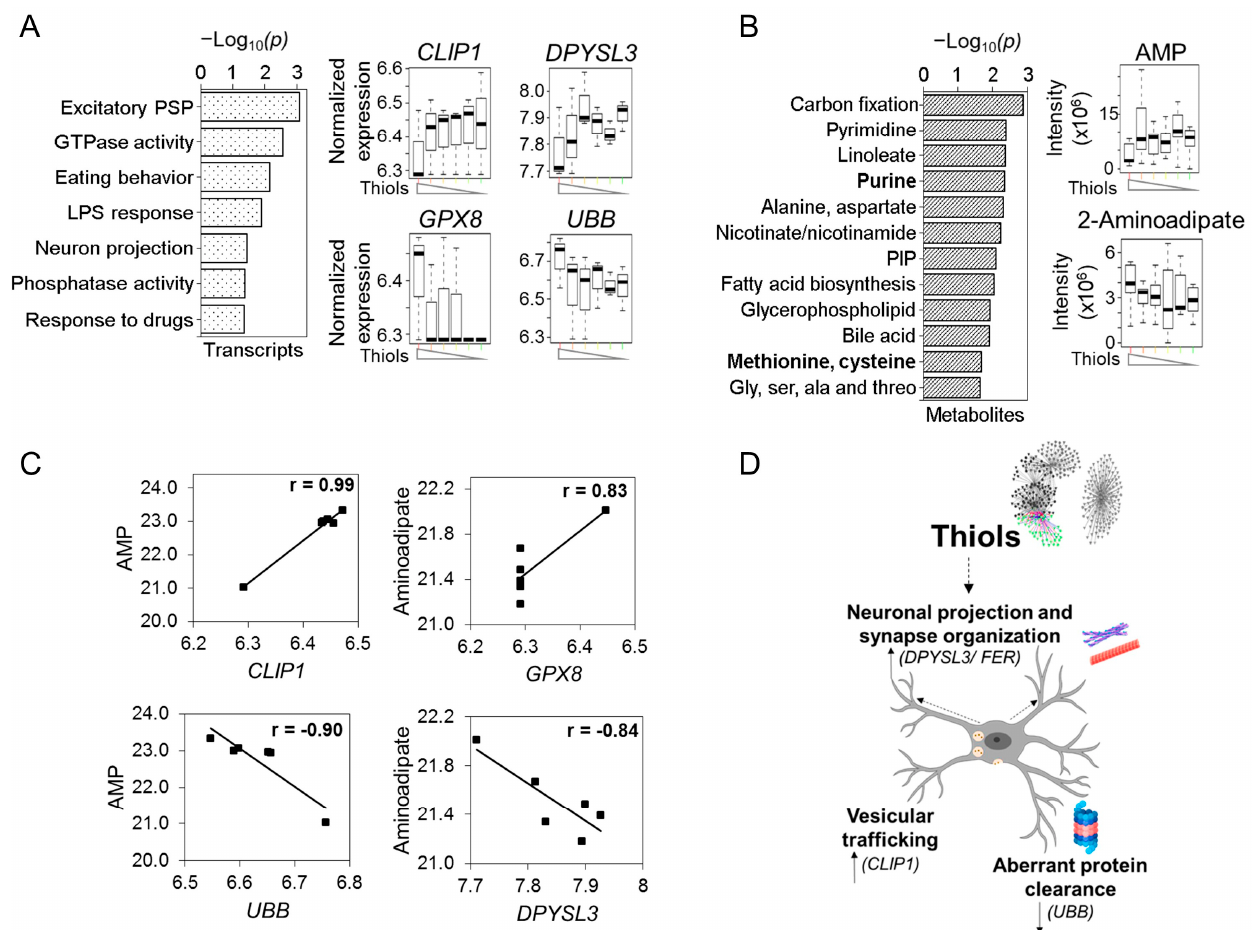
Figure 4. Community 2b: cellular oxidative stress subnetwork associated with signaling markers for neuronal projection, vesicular tra ffi cking and aberrant protein clearance. Pathway enrichment analysis of genes and metabolites associated with total cellular thiols subnetwork was studied. ( A ) Top pathways enriched with total cellular thiol dependent genes at p < 0.05, represented as − log 10 P.